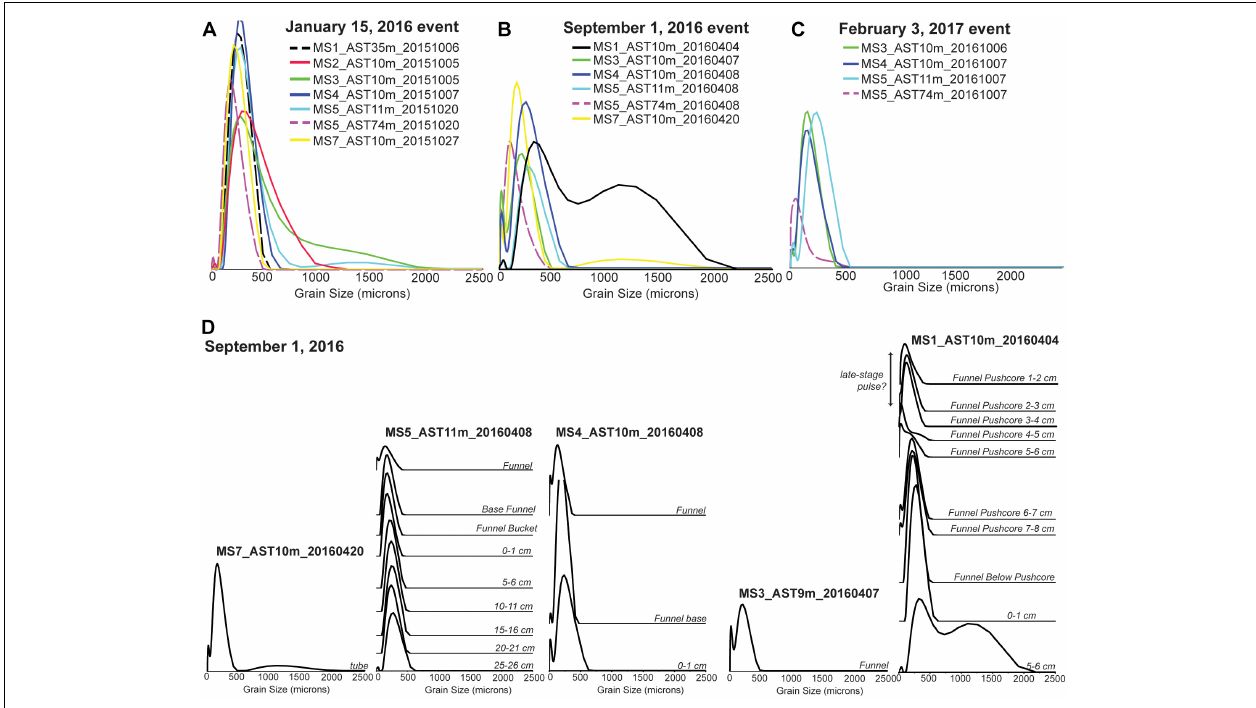
FIGURE 5 | Grain-size distributions from sediment density flow event units in sediment traps. Solid lines indicate samples from traps deployed at ∼ 10 m above the seafloor (masf), and dashed lines indicate samples from traps deployed at > 10 masf. (A) January 15, 2016 event. (B) September 1, 2016 event. (C) February 3, 2017 event. (D) Stratigraphy of the September 1, 2016 event shown as grain-size distributions down-canyon ( right to left , as in Figure 1